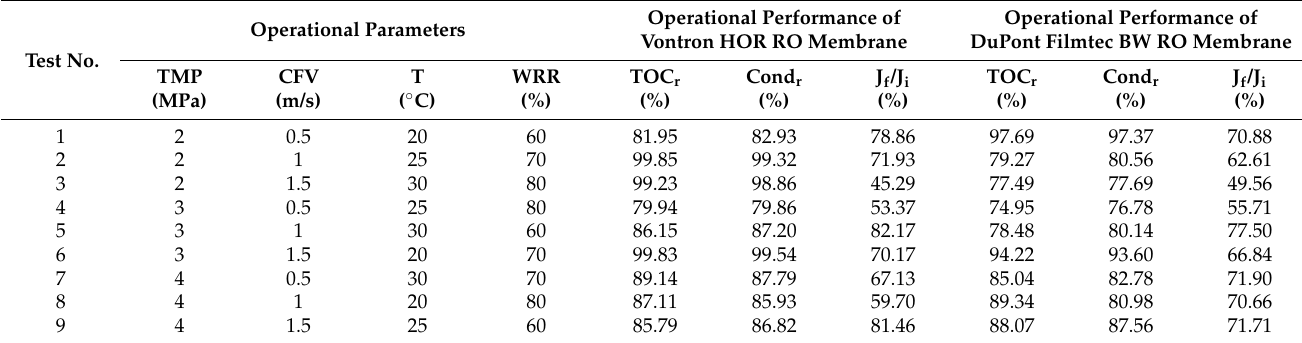
Table 5. Results of the orthogonal tests for candidate RO membranes.